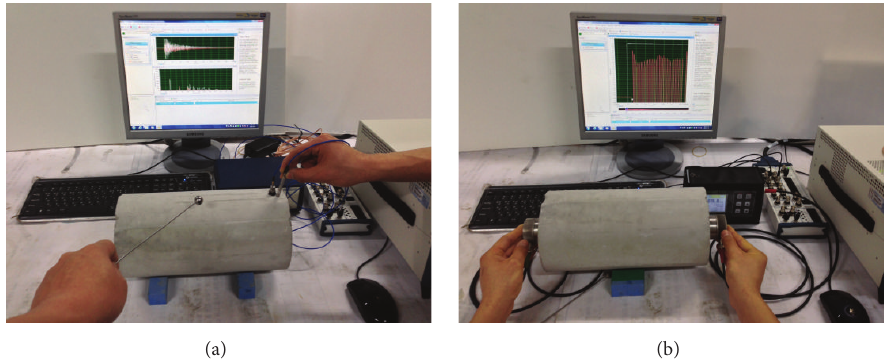
Figure 2: Test setups and data acquisition system for evaluating dynamic elastic moduli using two different nondestructive evaluation tests: